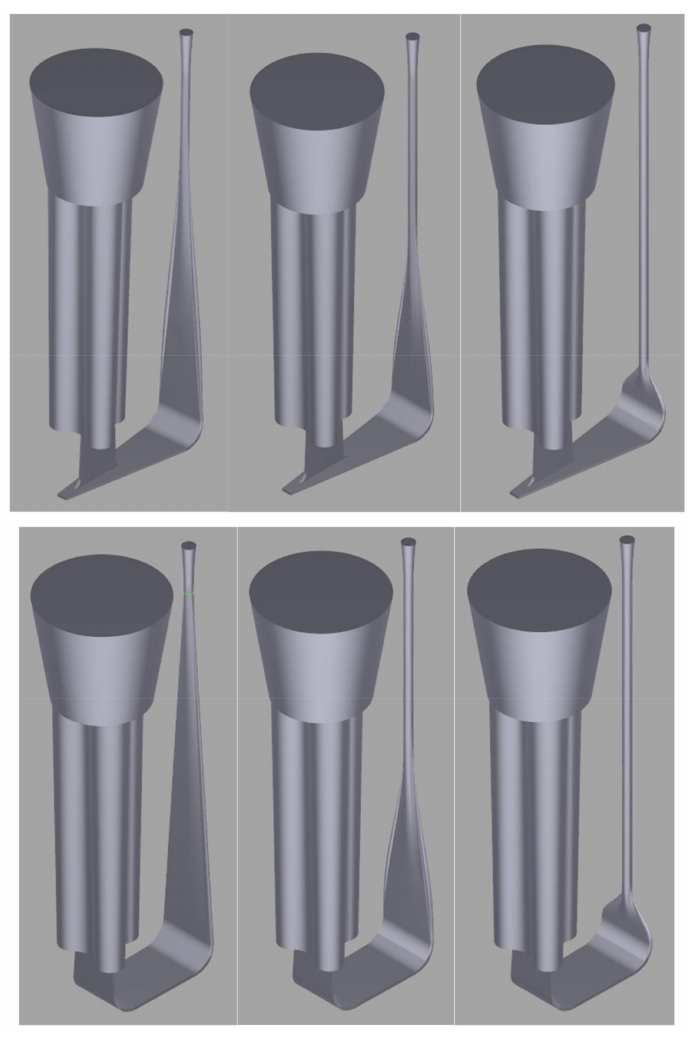
Figure 3. Various modifications of the gating system (downsprue)